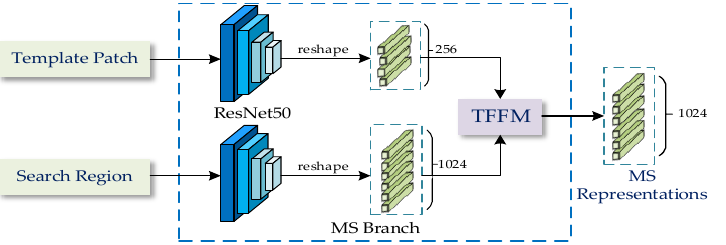
Figure 3. The MS branch’s structure. The input is the template patch and search region, and the output is the MS representations. Two sub-branches are used to process the template patch and the search region, respectively. Then disseminate the template information to the search information through the Transformer-based Feature Fusion Module (TFFM) to obtain the MS representations.